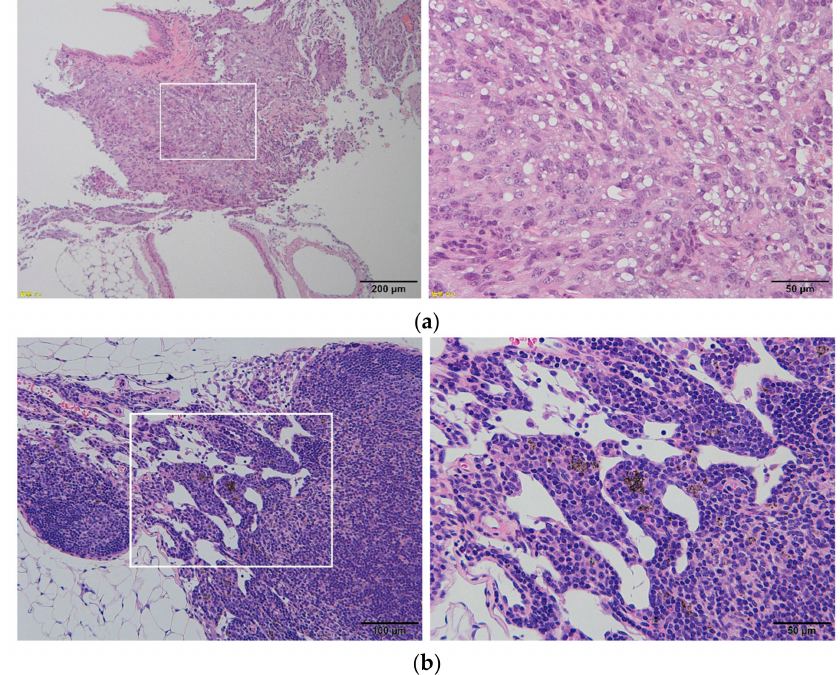
Figure 5. ( a ) Formation of Mesothelioma in the lung of rasH2 mice intravenously administered with MWCNTs. The right is an enlarged image of the square in the left image; ( b ) histological image of the pancreas in rasH2 mice administered intravenously with MWCNTs. Particles of MWCNTs are deposited in the tissue. There is no tumor formation. The right is an enlarged image of the square in the left image. Images are modified from a study by Sobajima et al.